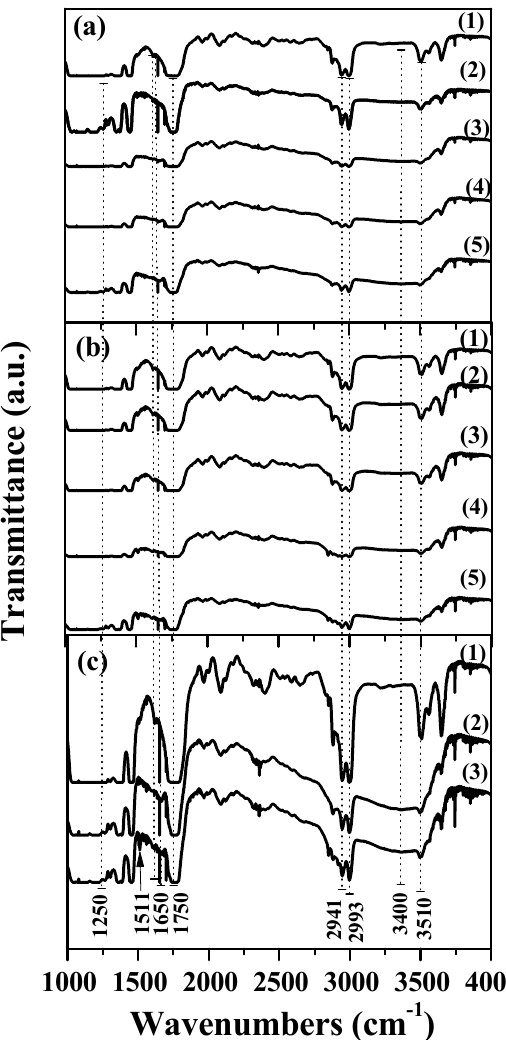
Figure 3. FT-IR spectra plots of ( a ) (1) PLLA (2) PLLA/CS5, (3) PLLA/CS10, (4) PLLA/CS20, and (5) PLLA/CS30; ( b ) (1) PLLA (2) PLLA/CS/BO5, (3) PLLA/CS/BO10, (4) PLLA/CS/BO20, and (5) PLLA/CS/BO30; and ( c ) (1) PLLA, (2) PLLA/CS30, and (3) PLLA/CS/BO30.